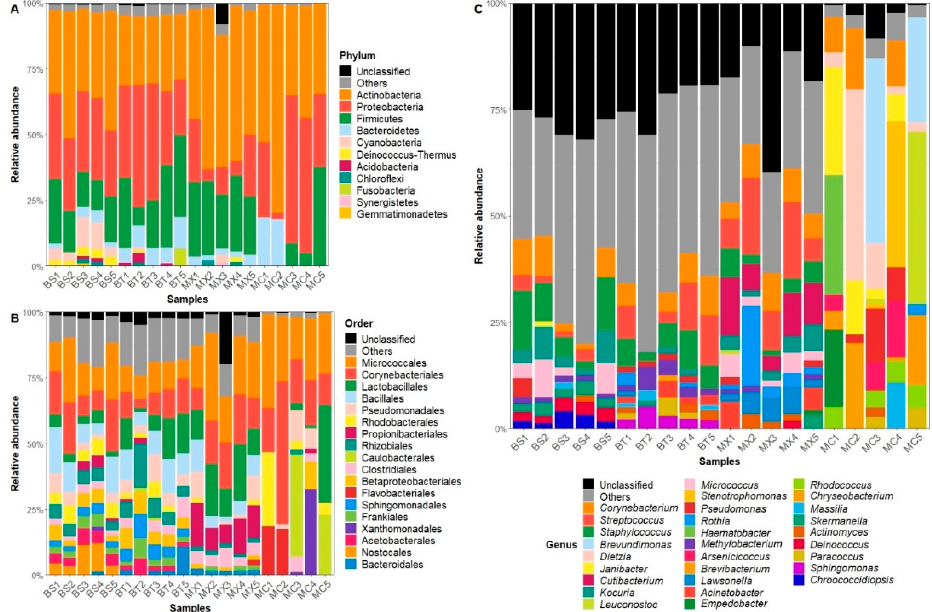
Figure 2. Relative abundance of major bacteria in BS, BT, MX, and MC samples (%) at the ( A ) phylum, ( B ) order, and ( C ) genus levels. Taxa with a relative abundance of ≥ 1% are indicated.